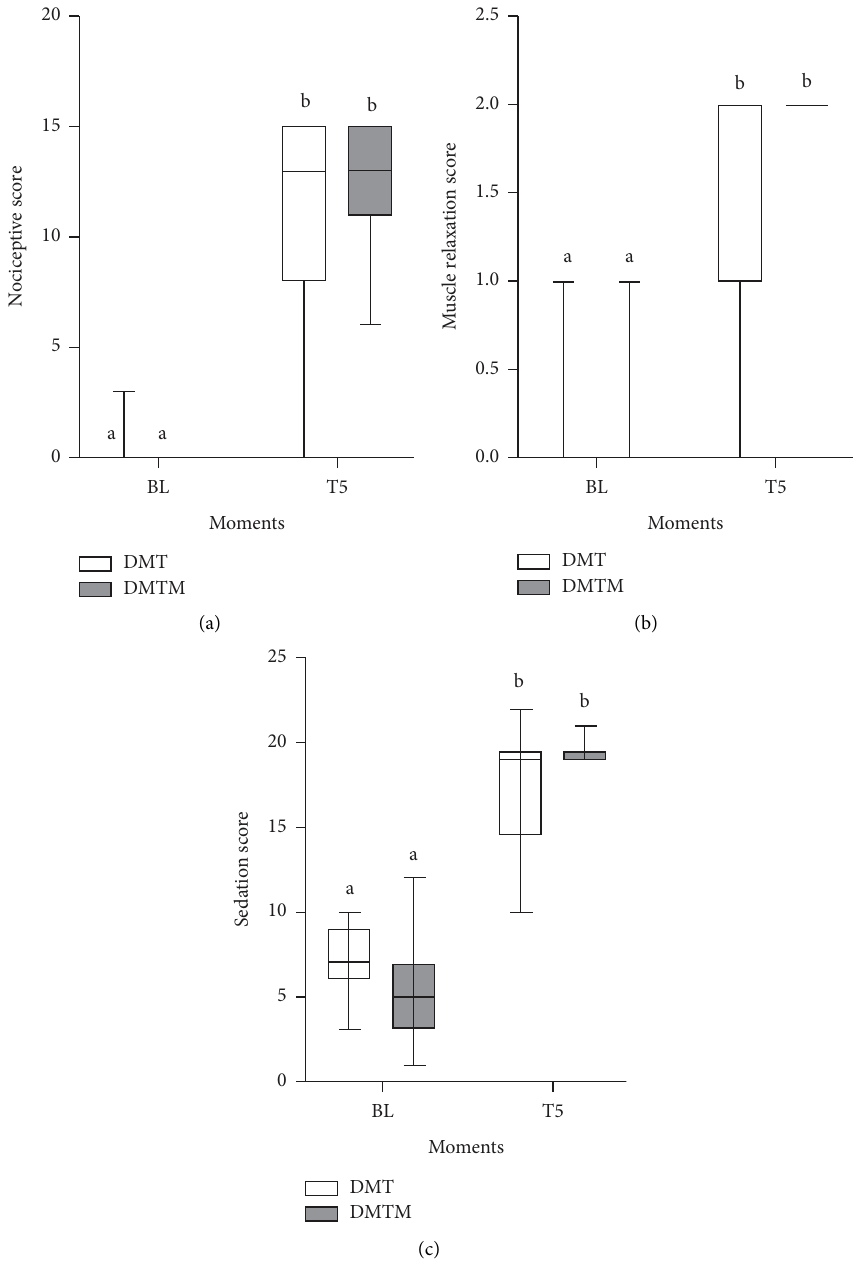
Figure 11: Sedation scores, nociceptive response, and muscle relaxation were observed in 18 cats sedated with the combination of dexmedetomidine (7.5ug/kg) and methadone (0.3mg/kg) (DMT, n � 9) or dexmedetomidine (5ug/kg). kg), methadone (0.3mg/kg), and midazolam (0.3mg/kg) (DMTM, n � 9), both by the intramuscular route. Maximum scores for possible sedation, nociceptive response, and muscle relaxation are 19, 15, and 2, respectively. Values are presented as “boxplots,” with 50% of the data contained in the box. Te bold horizontal line represents the median and the bars represent the score variation. a, b: diferent lowercase letters indicate a signifcant diference between moments within the same group according to the Wilcoxon test ( p < 0 .